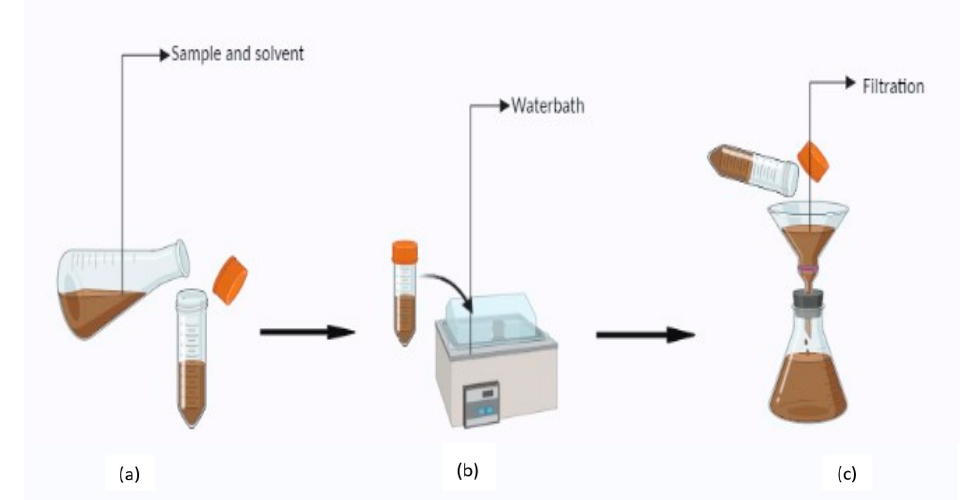
Figure 3. A diagrammatic representation of decoction extraction. ( a ) Sample placed in a capped glass tube, then a ( b ) water bath for 65–70 °C for 30 min to 2 h. ( c ) Filtration of the extract.